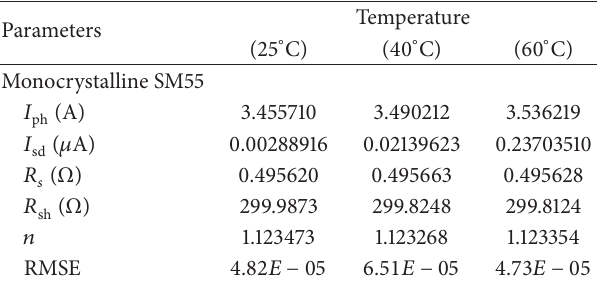
Table 16: The extracted parameters for three different types of PV modules by PCE at different values of irradiance and temperatures of 25 ∘